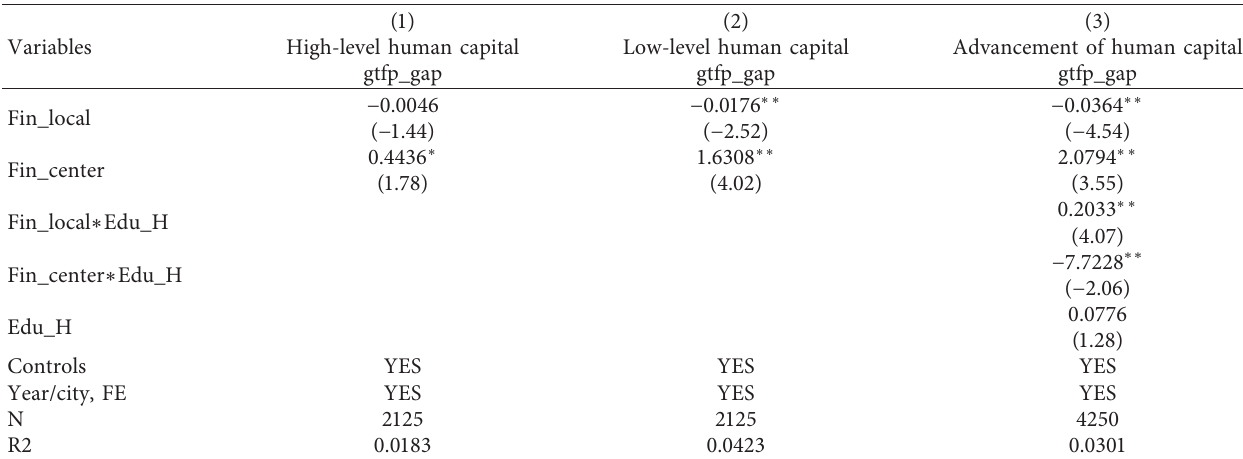
Table 5: Interaction of human